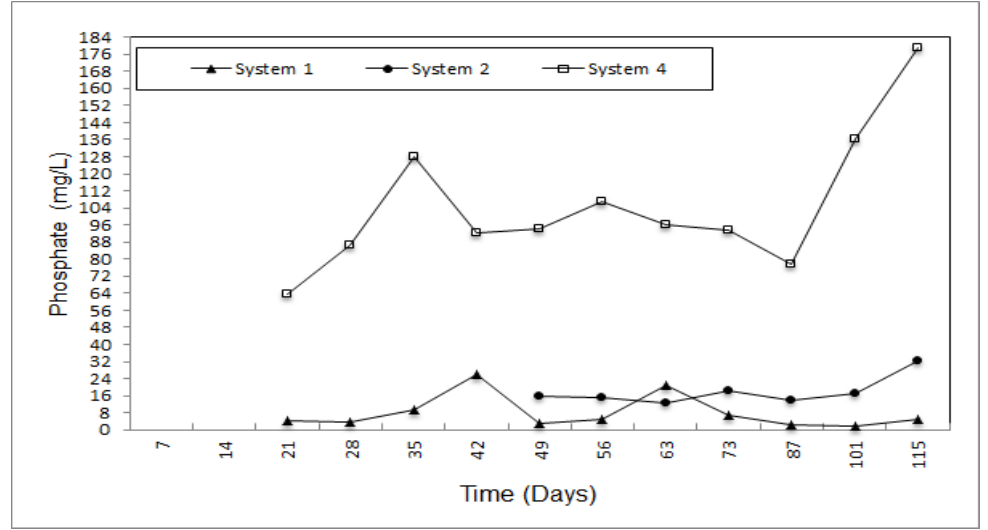
Figure 7. Phosphate concentration of the leachate.